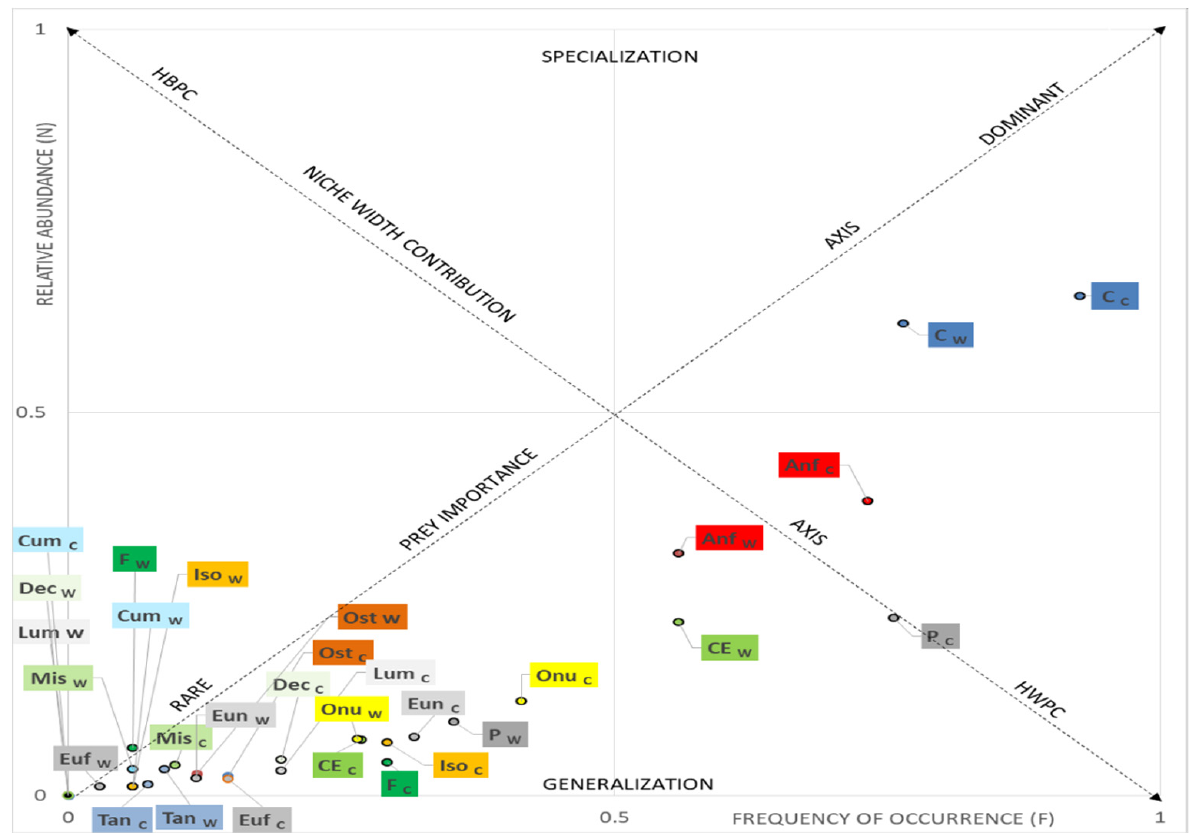
Figure 5. Costello’s diagram representing temporal variation in the diet of Coelorinchus caelorhincus based on prey found at the macro-taxa level (F: Fish; C: Crustaceans; P: Polychaetes; CE: Cephalopods) and micro-taxa level (Anf: Amphipods; Iso: Isopods; Mis: Mysids; Dec: Decapods; Tan: Tanaids; Ost: Ostracods; Euf: Euphausids; Cum: Cumaceans; Onu: Onuphids; Eun: Eunicids; Lum: Lumbrinerids) as identified in the stomachs of a sample from Central Thyrrhenian sea. The same background color indicates same prey, and ‘W’ and ‘C’ subscripts stand for the warm and cold period, respectively.